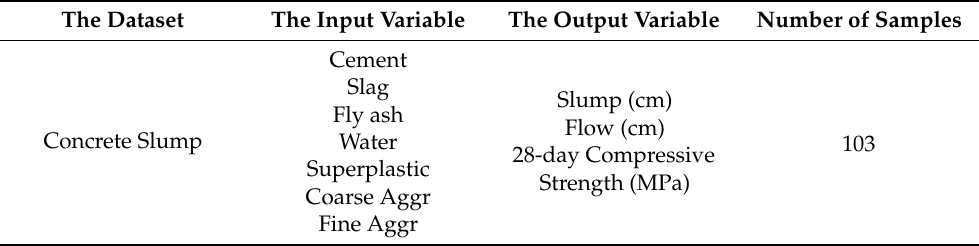
Table 1. Information of Concrete Slump dataset.